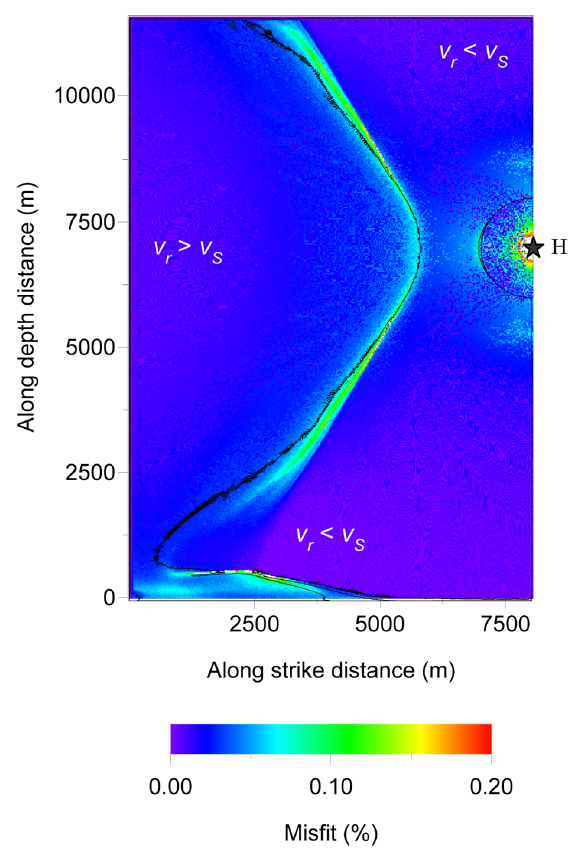
cri- l . The quantity m re- u